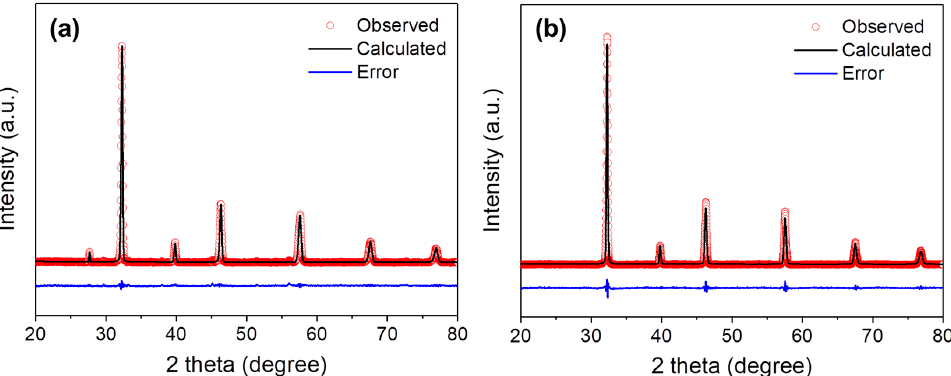
Figure 3. Rietveld refinements of room temperature XRD patterns of SFMO powders prepared from direct sintering program ( a ) and stepwise sintering program ( b ).